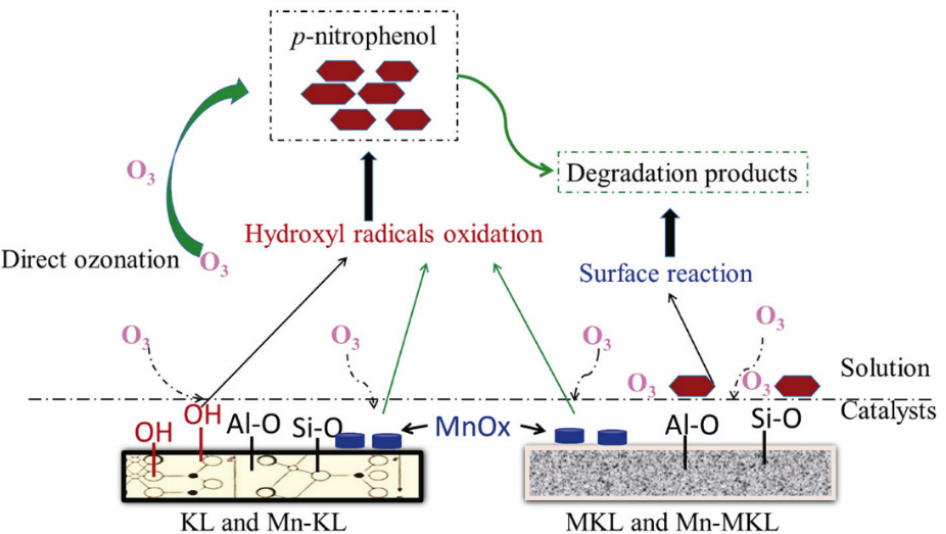
Figure 2. Proposed ozonation mechanism of p-nitrophenol in catalytic ozonation treatments using kaolinite-based catalysts [124] (reprinted from Publication Appl. Clay Sci. 175, W. Ma, J. Hu, B. A. Yoza, Q. Wang, X. Zhang, Q. X. Li, S. Guo, C. Chen, Kaolinite based catalysts for efficient ozonation